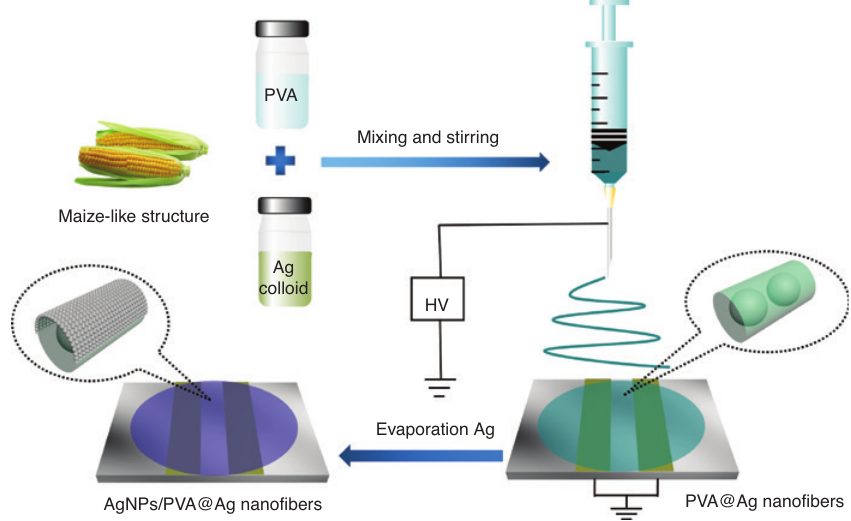
Figure 1: Schematic illustration of the process for the synthesis of the highly sensitive 3D porous AgNPs/PVA@Ag nanofibers SERS